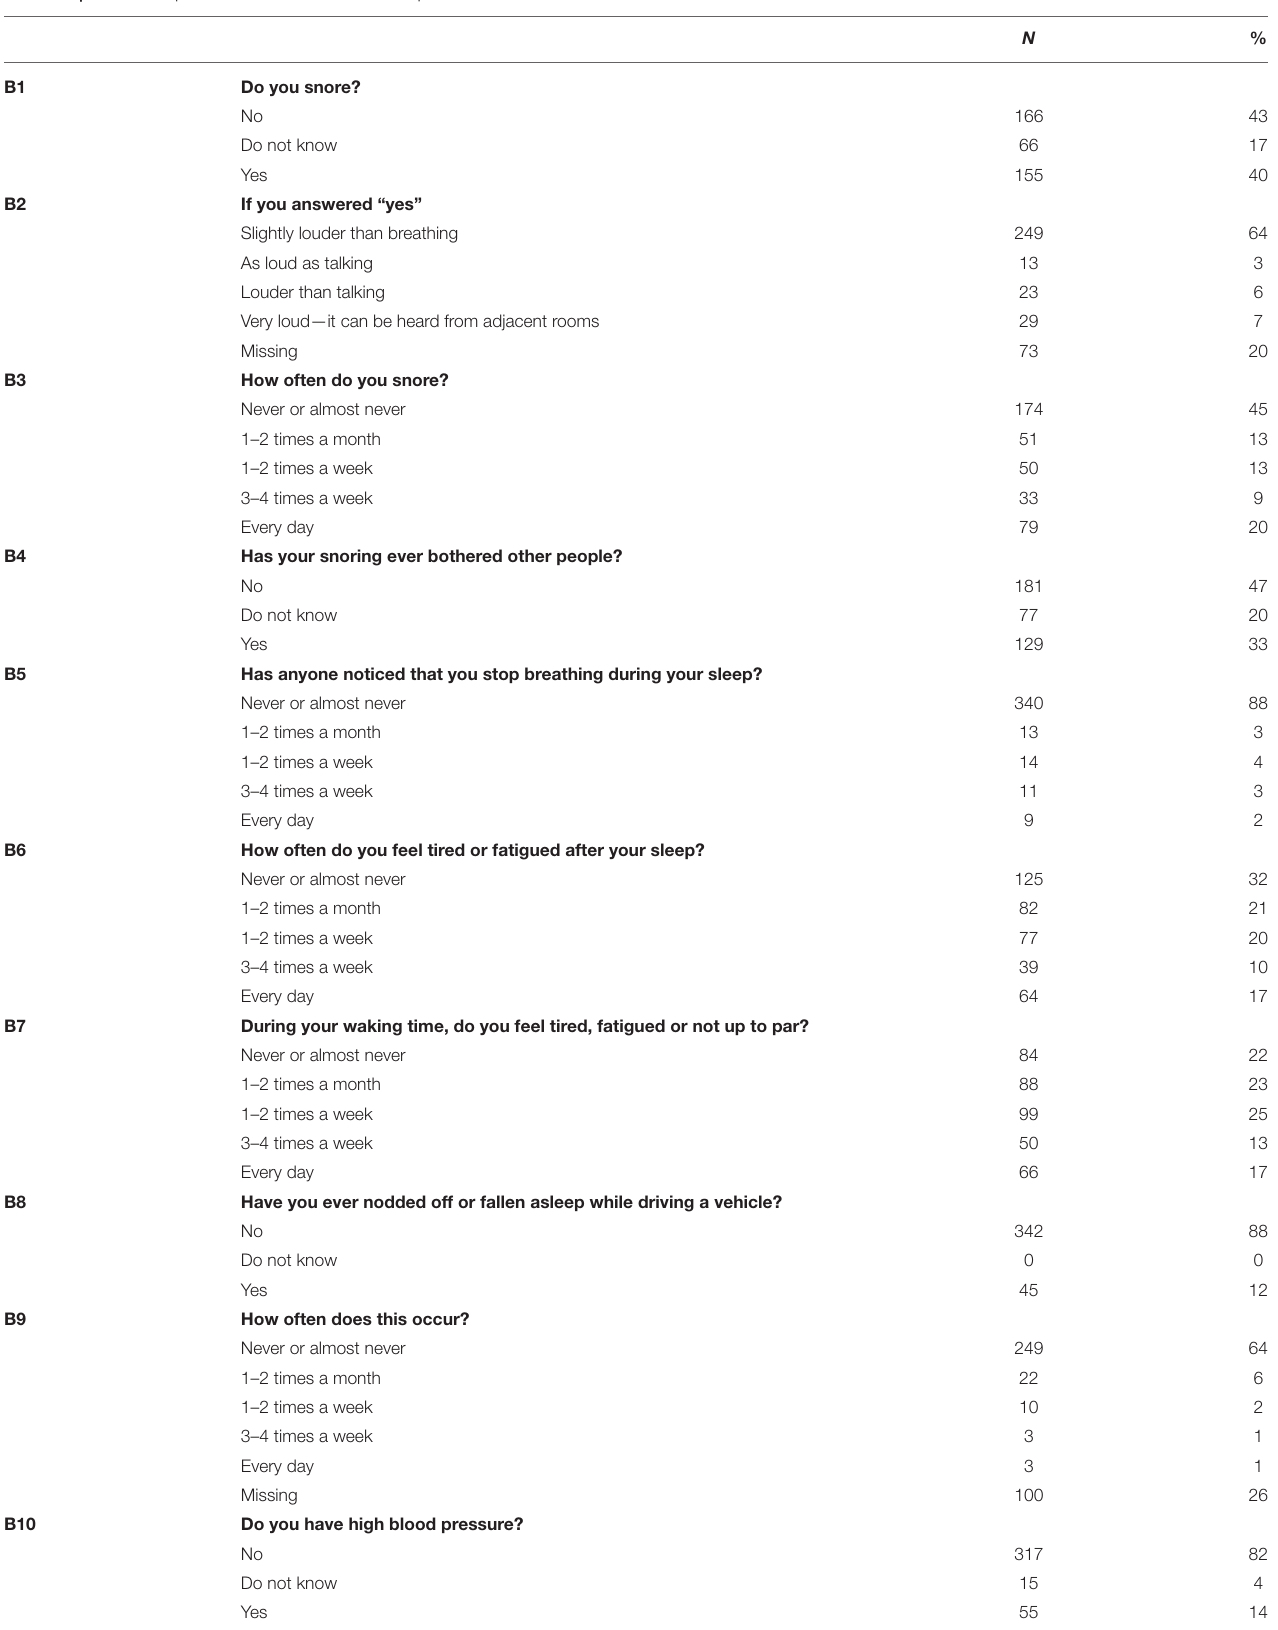
TABLE 1 | The Berlin questionnaire evaluated for all